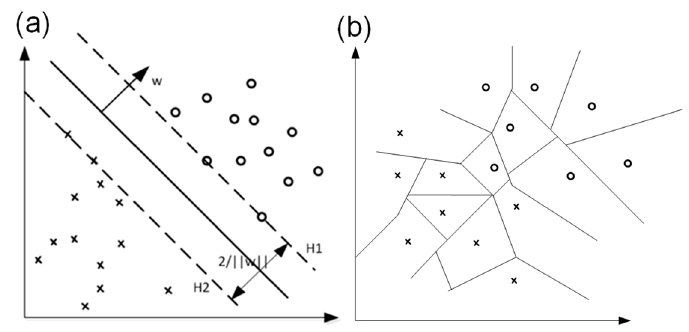
Figure 7. Prediction principle of the SVC and KNN algorithm. ( a ) Schematic diagram of SVC for maximizing interval in two-dimensional feature space. ( b ) A division of two-dimensional feature space by KNN.